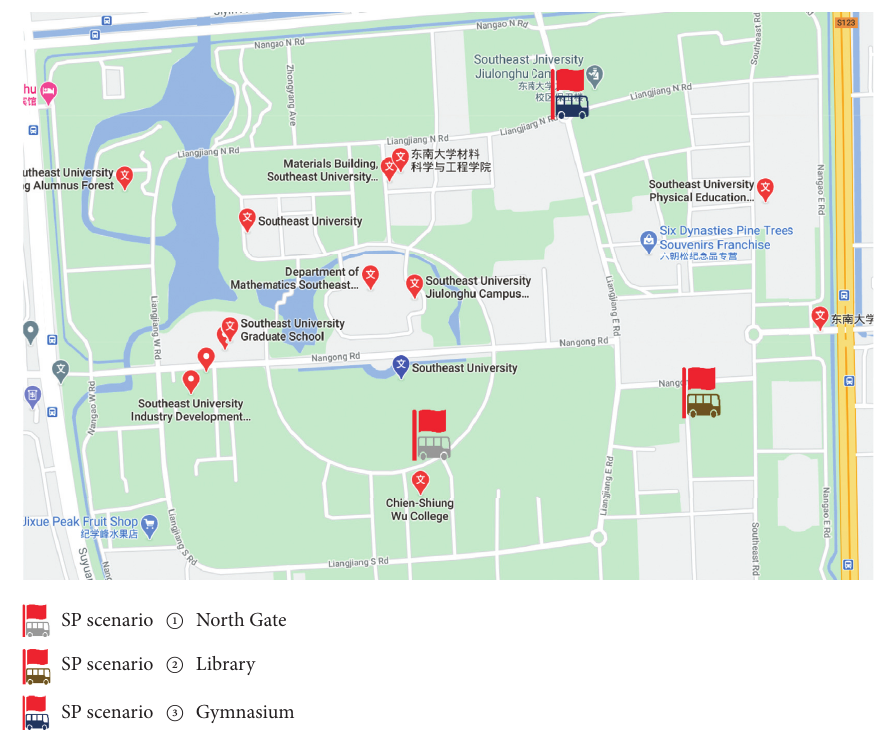
Figure 3: Location of shared bus platform in three SP survey